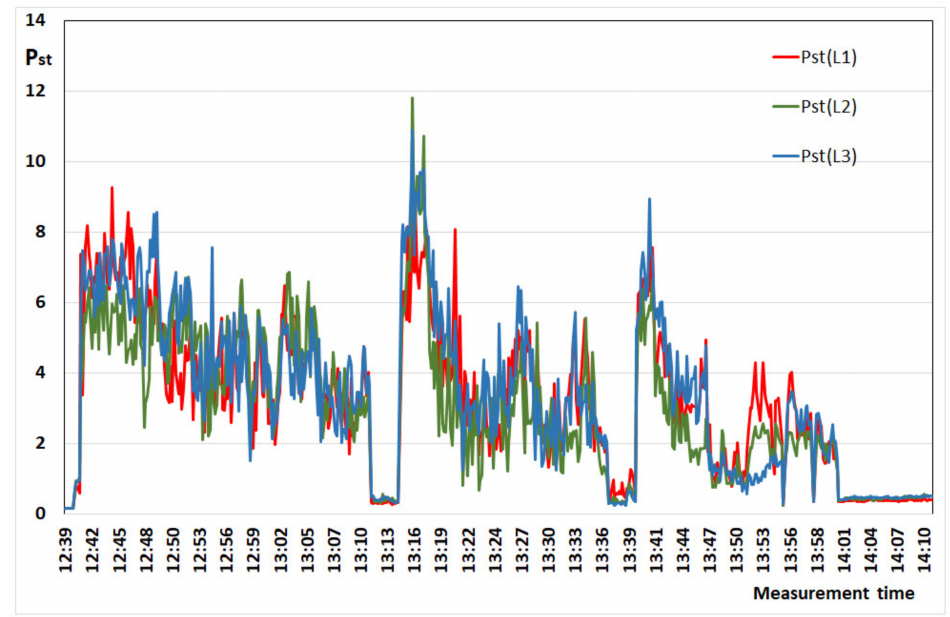
Figure 16. Changes in the short-term flicker severity P st recorded during one melt in the arc furnace.